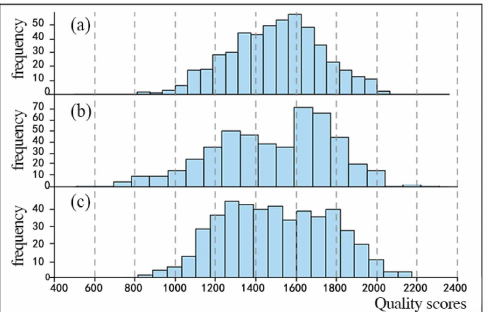
Figure 10. Change trend of the rank difference value. ( a ) Arterial road; ( b ) Secondary trunk road; ( c ) Branch road.